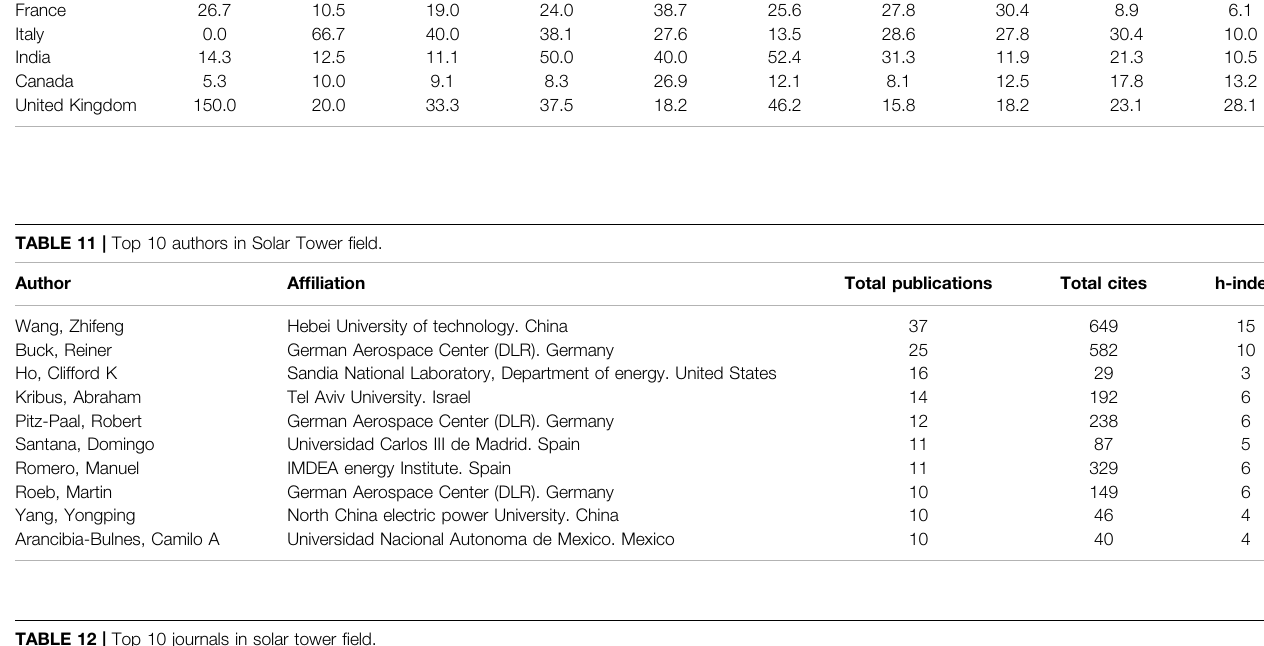
TABLE 12 | Top 10 journals in solar tower fi eld.